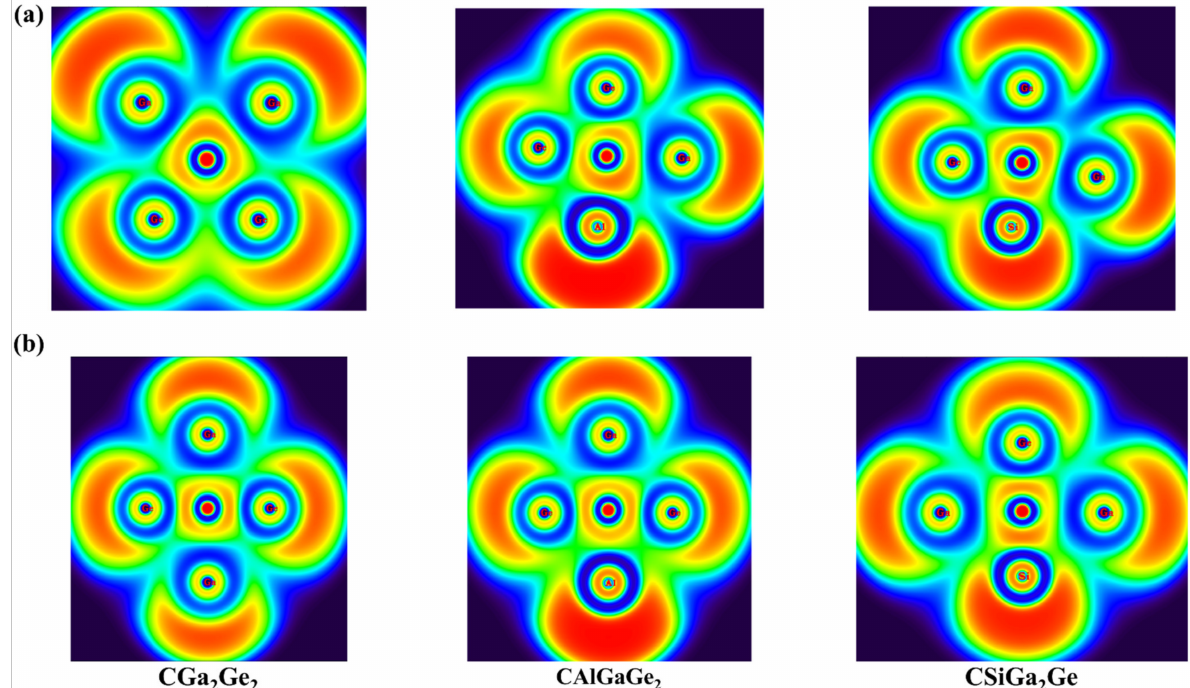
Figure 9. The color-filled plots of the electron localization function (ELF) basin for ( a ) cis isomer; ( b ) trans isomer, for CGa 2 Ge 2 , CAlGaGe 2 , and CSiGa 2 Ge